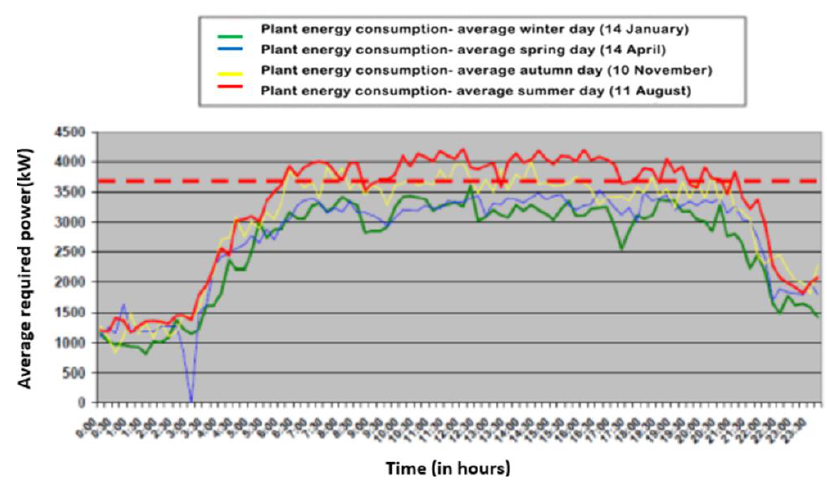
Figure 2. Electricity consumption profile in the factory during four periods.